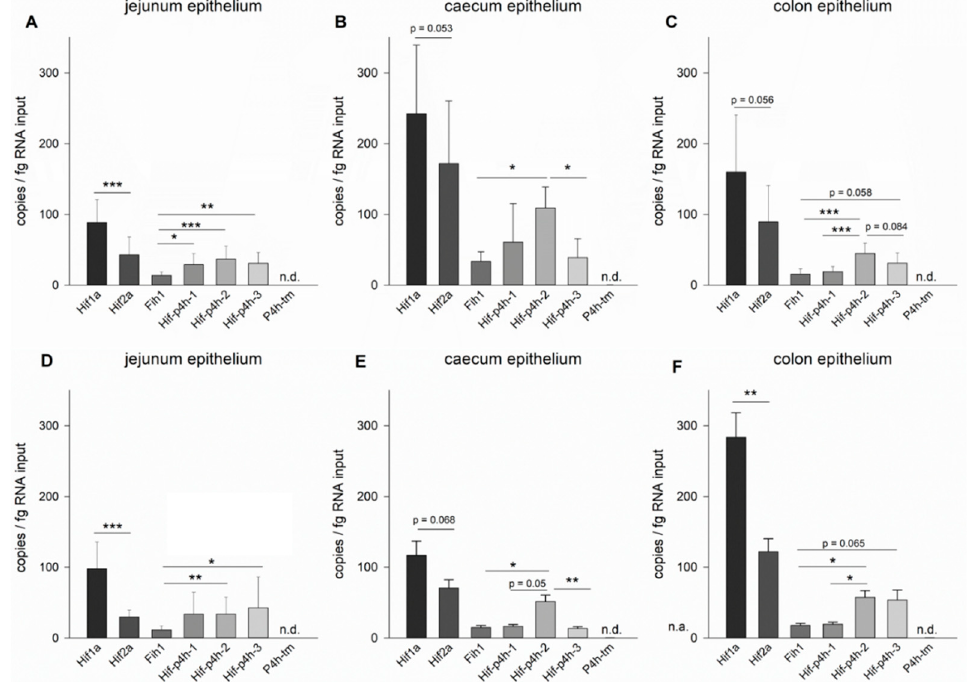
Figure 1. Expression of HIF pathway components in the epithelium of the murine gastrointestinal tract. mRNA expression levels of Hif1a , Hif2a , Fih1 , Hif-p4h isoforms 1 , 2 , 3 and P4h-tm at 8 ( A – C ) and 16 ( D – F ) weeks of age in wild-type mouse jejunum ( A , D ), caecum ( B , E ) and colon ( C , F ) epithelium assessed by ddPCR; n = 14 for ( A , D ), and 8 for ( B , C , E , F ); data are presented as means ± SD, One-Way RM ANOVA and subsequent Tukey test, asterisks indicate significant differences between the genes ( Hif1a vs. Hif2a and Hif-p4h-1 vs. 2 vs. 3 vs. Fih1 ), * p < 0.05, ** p < 0.01, *** p < 0.001; n.d.: not